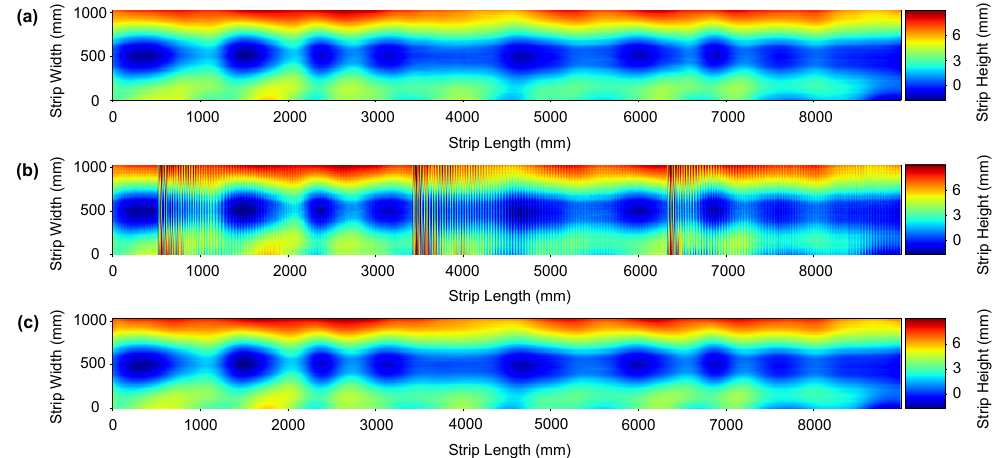
Figure 13. An instance of a real metal sheet surface denoising. Plate thickness: 6mm; yield point Re: 500 MPa; Dimension of the mother plate—length: 9 m; width: 1050 mm. ( a ) Hermite filter denoised ground truth surface, ( b ) noise corrupted surface and ( c ) denoised reconstructed surface using the proposed network. (Color online).